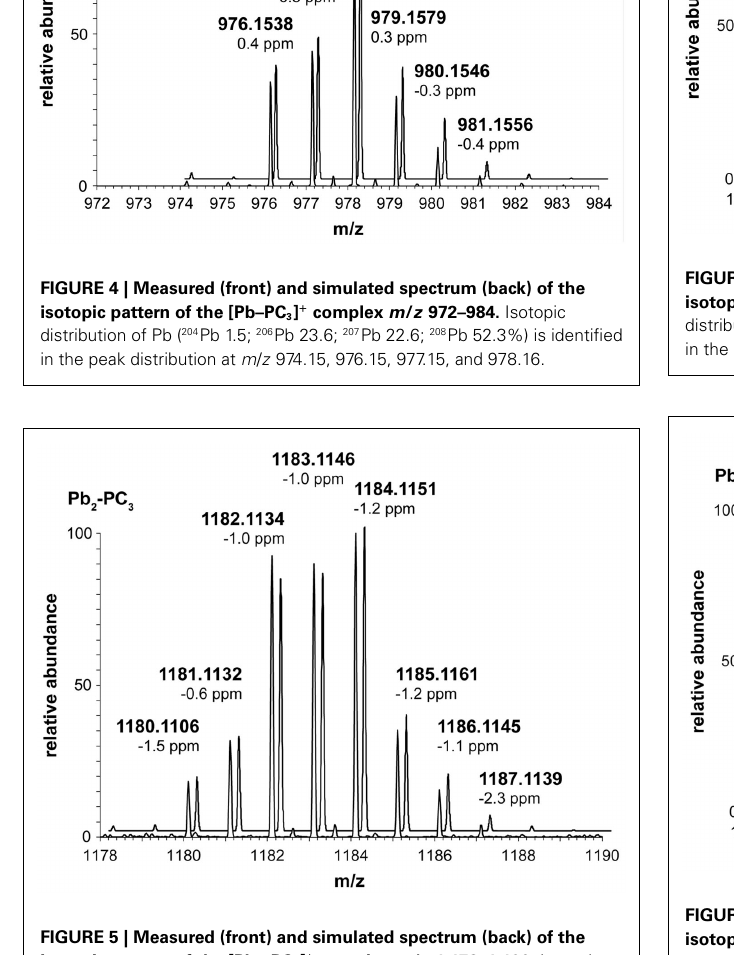
FIGURE 5 | Measured (front) and simulated spectrum (back) of the isotopic pattern of the [Pb 2 –PC 3 ] + complex m / z 1,178–1,190. Isotopic distribution of two Pb ( 204 Pb 1.5; 206 Pb 23.6; 207 Pb 22.6; 208 Pb 52.3%) is identified in the peak distribution of the m / z 1180.11–1184.12.